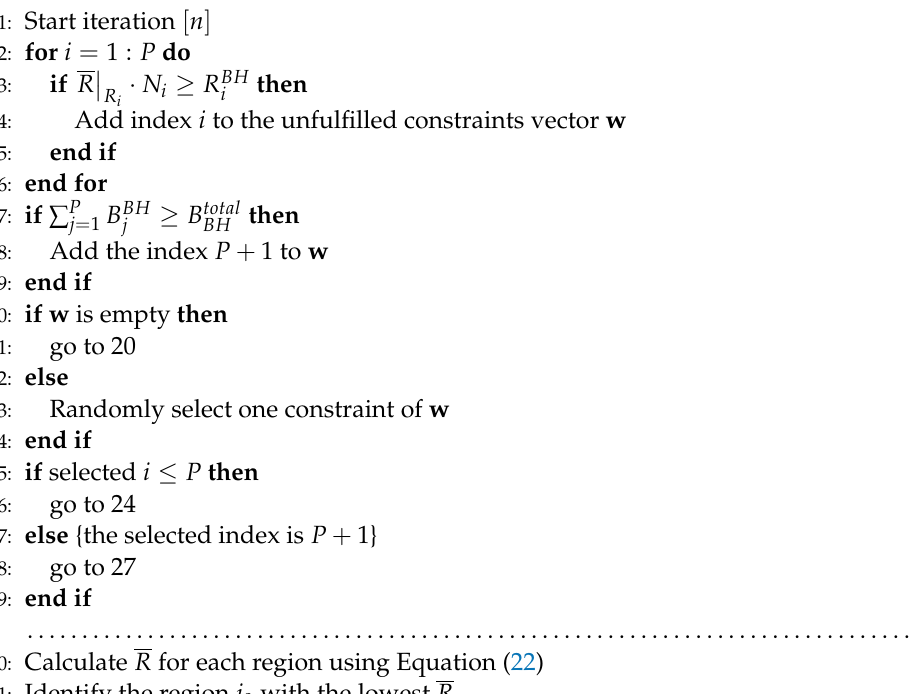
Algorithm 1 Positioning